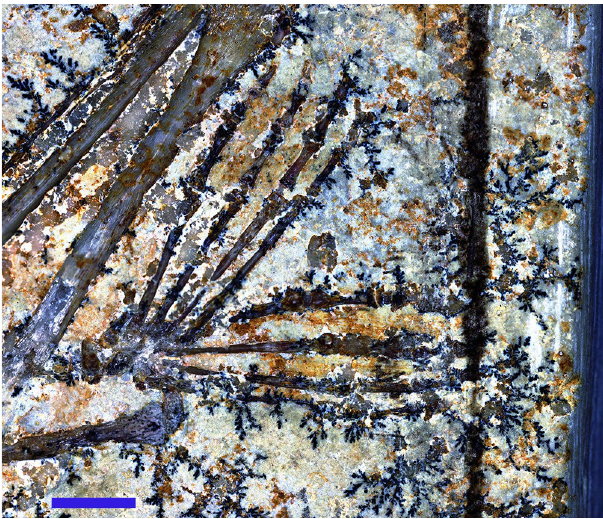
Figure 3. Webbed feet in the aurorazhdarchid pterosaur specimen MB.R.3531a. Parallel actinofibral-like fibres extend from the base of the toes to the base of the claws. Enhanced white light image. Scale = 4